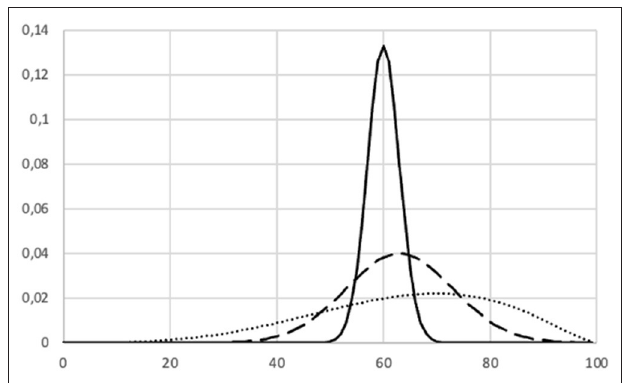
FIGURE 11 | Three probability densities representing a proxy variable for